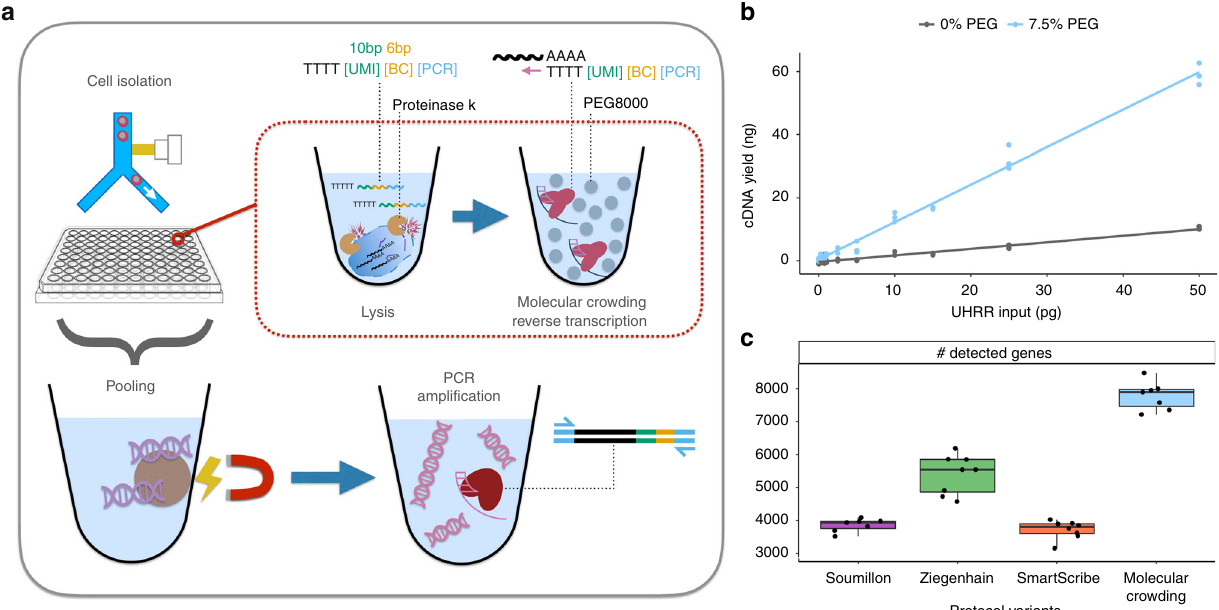
Fig. 1 mcSCRB-seq work fl ow and the effect of molecular crowding. a Overview of the mcSCRB-seq protocol work fl ow. Single cells are isolated via FACS in multiwell plates containing lysis buffer, barcoded oligo-dT primers, and Proteinase K. Reverse transcription and template switching are carried out in the presence of 7.5% PEG 8000 to induce molecular crowding conditions. After pooling the barcoded cDNA with magnetic SPRI beads, PCR ampli fi cation using Terra polymerase is performed. b cDNA yield dependent on the absence (gray) or presence (blue) of 7.5% PEG 8000 during reverse transcription and template switching. Shown are three independent reactions for each input concentration of total standardized RNA (UHRR) and the resulting linear model fi t. c Number of genes detected (> = 1 exonic read) per replicate in RNA-seq libraries, generated from 10 pg of UHRR using four protocol variants (see Supplementary Table 1) at a sequencing depth of one million raw reads. Each dot represents a replicate ( n = 8) and each box represents the median and